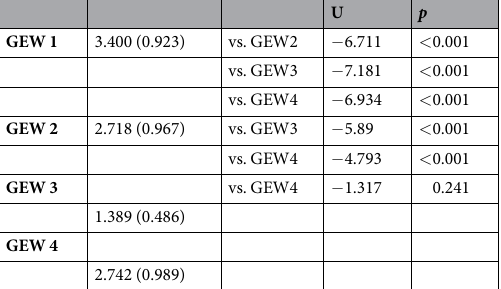
Table 3. Results obtained from Wilcoxon Test comparisons of different quadrants in the Geneva Emotion Wheel (GEW) - Mean number of self reported emotions